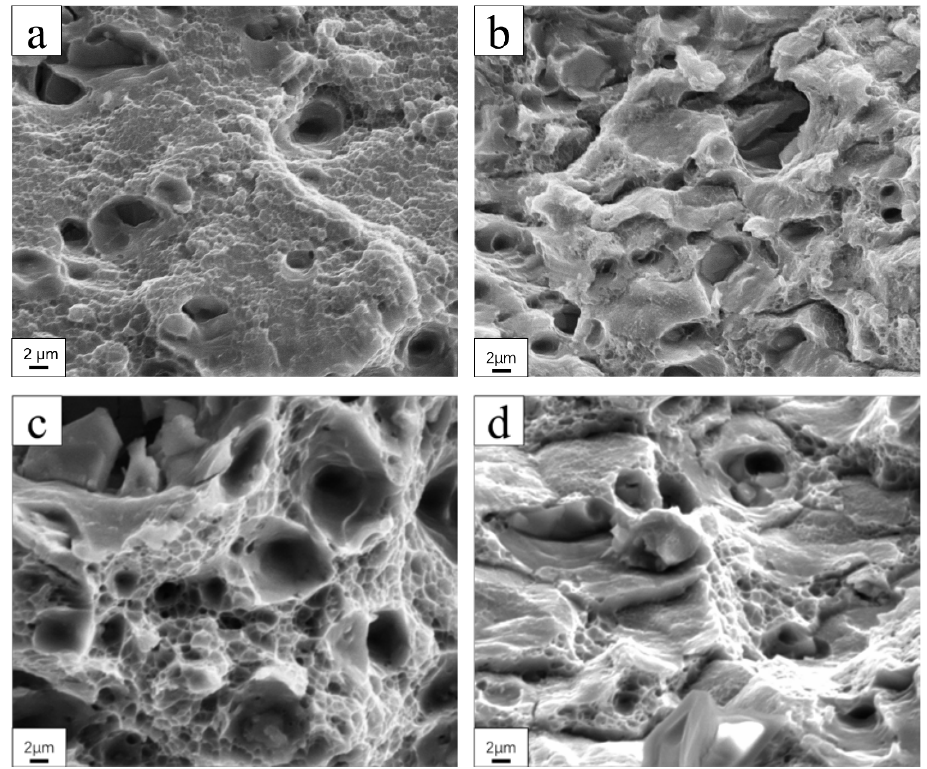
Figure 6. SEM images of fracture surface of tensile specimens under different conditions: ( a ) 0.3 mm, initial state; ( b ) 0.3 mm, 12 h aging at 453 K with stress of 90 MPa; ( c ) 1.5 mm, initial state; ( d ) 1.5 mm, 12 h aging at 453 K with stress of 90 MPa.